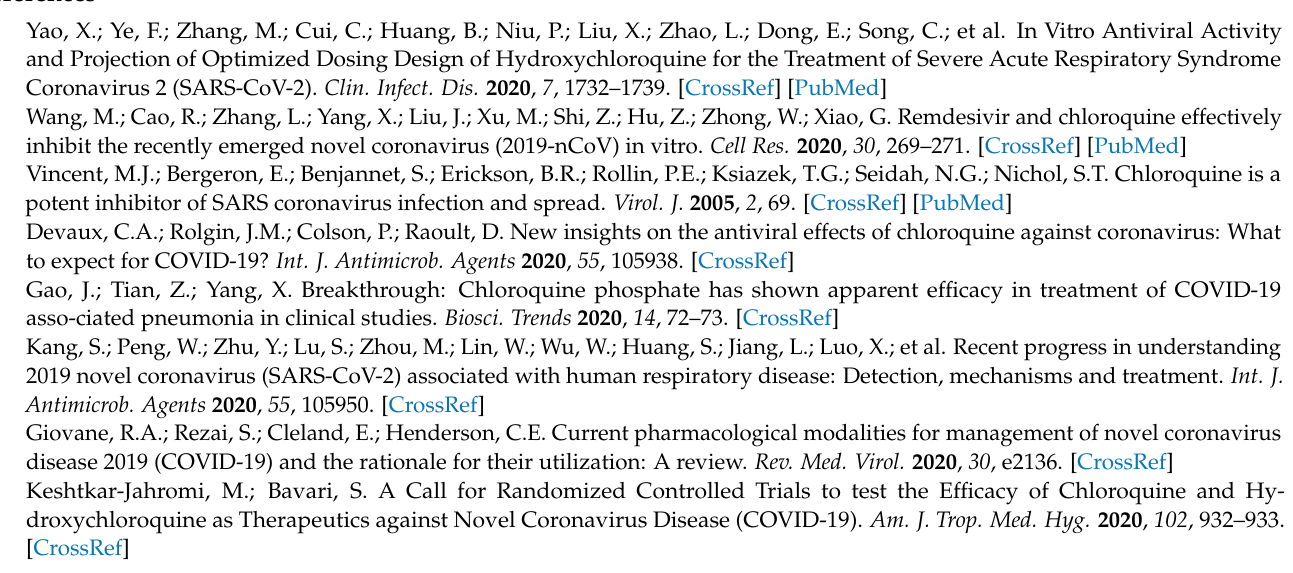
Table S22: characteristics of included studies: observational studies and clinical trials (COVID-19 treatment and